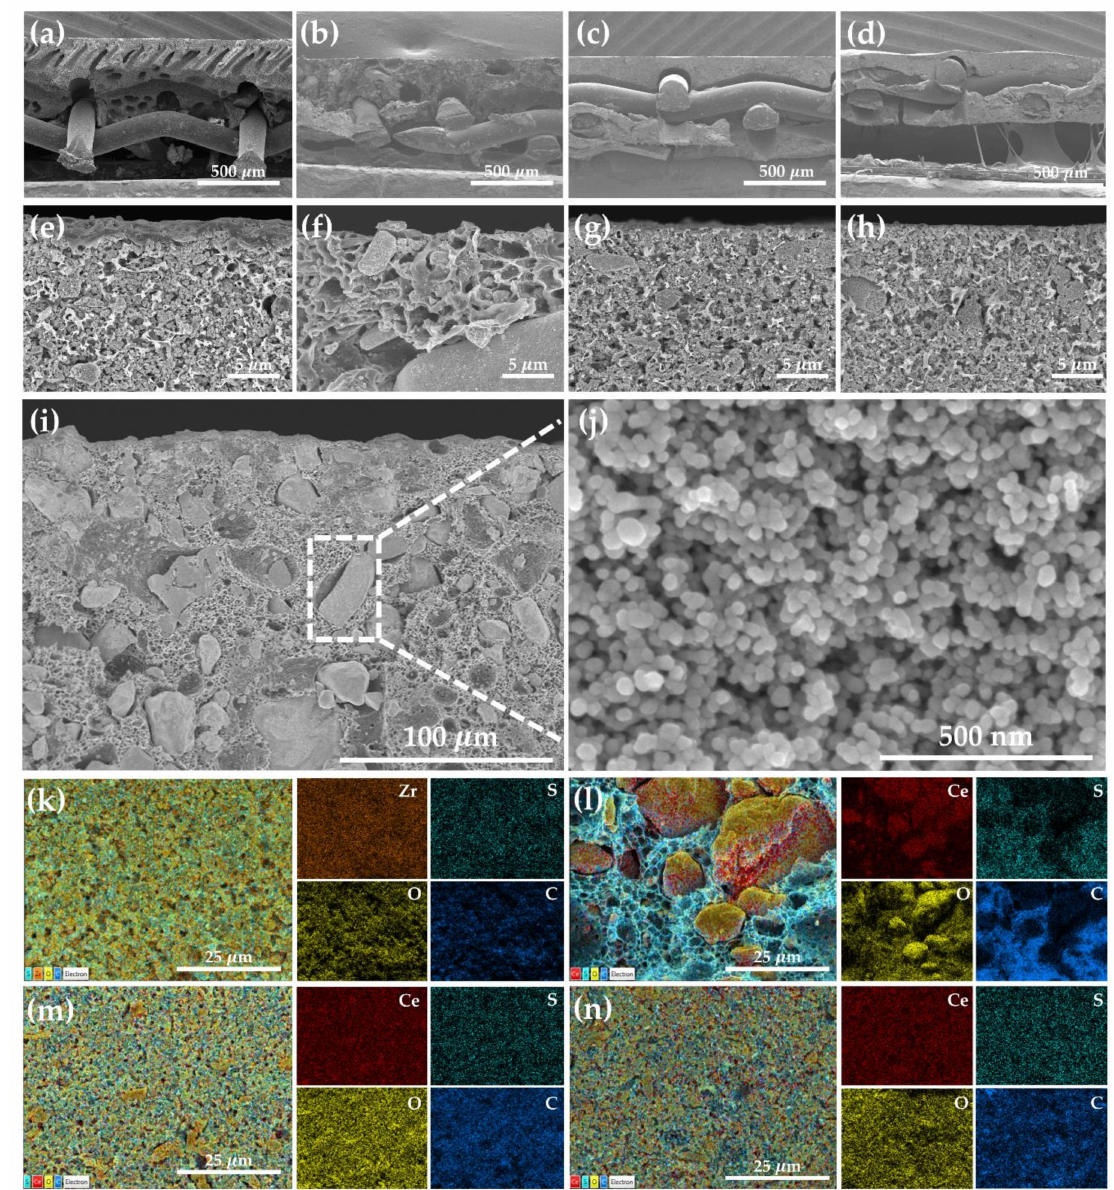
Figure 1. Cross-sectional SEM images, low-magnification ( a ) Zirfon, ( b ) C20 separator, ( c ) C50 separator, ( d ) C 100 separator and higher magnification ( e ) Zirfon, ( f ) C20 separator, ( g ) C50 separator, ( h ) C100 separator, and ( i ) aggregates of C20 separator ( j ) inset of agglomerated CeO 2